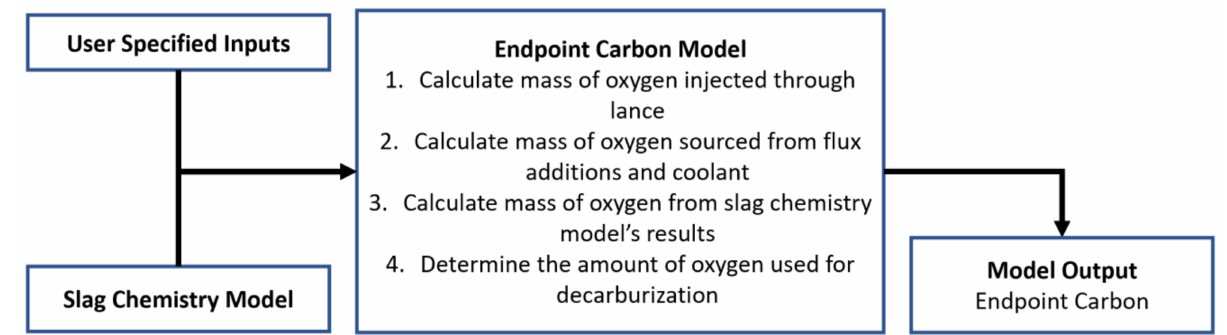
Figure 3. Flowchart of the endpoint carbon theoretical